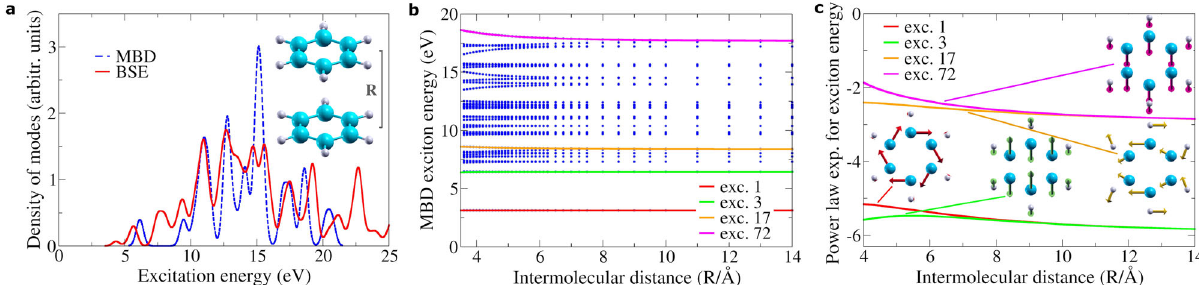
Fig. 2 Analysis of exciton spectra and optical vdW interactions in the benzene dimer. a Comparison between MBD and BSE excitation spectra for benzene. The MBD spectrum is rigidly shifted by + 3 eV. A Gaussian broadening of 0.3 eV was introduced in MBD and BSE calculations (and adopted hereafter). b MBD exciton energies for the benzene dimer as a function of the intermolecular distance R (in analogy to Fig. 1). Select exciton modes, relevant to our analysis (1,3,17,72) are highlighted with colored lines to facilitate visualization. The lowest-energy excitation with visible splitting (exc. 17) is at ~8.38 eV and involves sizeable dipole transition. Lower-energy modes (such as exc. 1,3) undergo smaller splitting due to more complex charge rearrangement. c Power-law exponents for select excitation modes (highlighted in b ), computed as the slope of the MBD exciton energy vs. R in logarithmic scale 35 . The geometry of these modes is displayed in schematic form, with arrows indicating atomic dipoles. Modes 17 and 72 have fi nite (overall) dipole moments and exhibit an asymptotic behavior of R − 3 , whereas modes 1 and 3 have negligible dipole moment, and show ~ R − 6 power law.